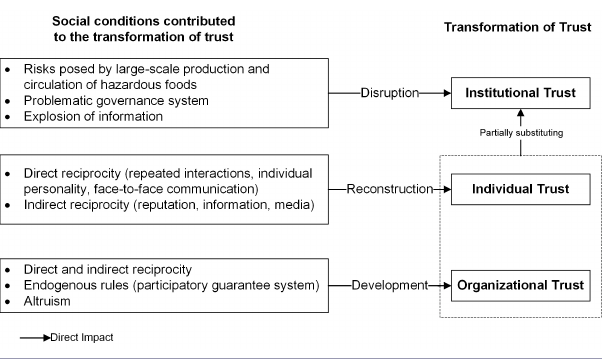
Fig. 1 . The transformation of trust in China's alternative food